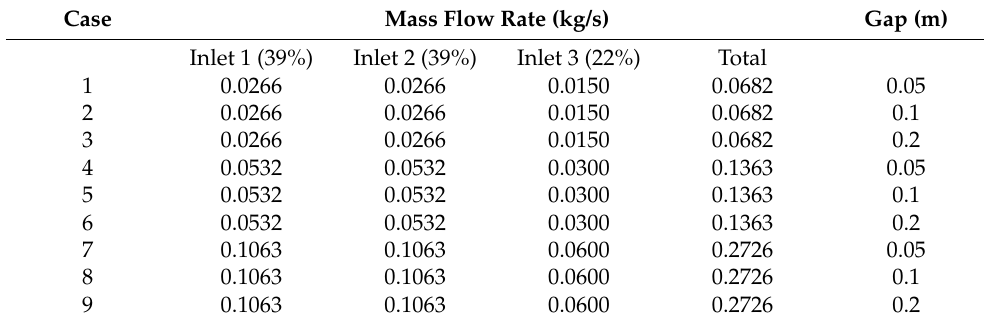
Table 2. Parametric study for the cabin underfloor equipment bay (Configuration 2).